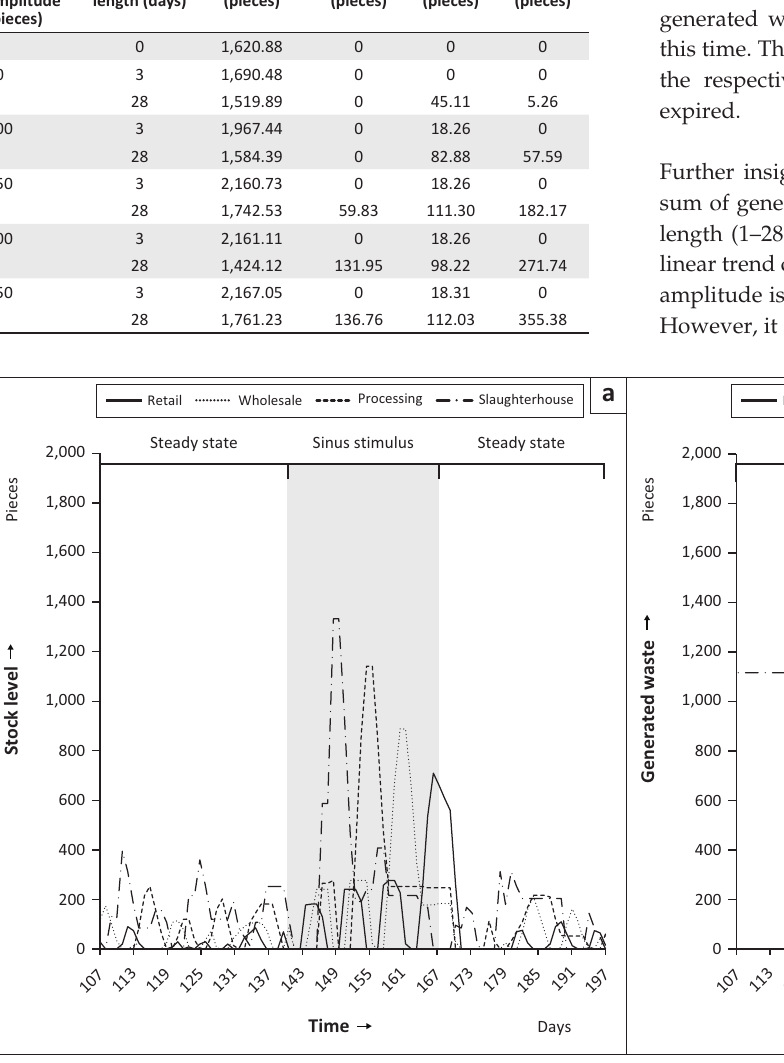
TABLE 5: Generated waste for each amplitude spectrum for a 3- and 28-days long sinusoidal stimulus (mean value). Input